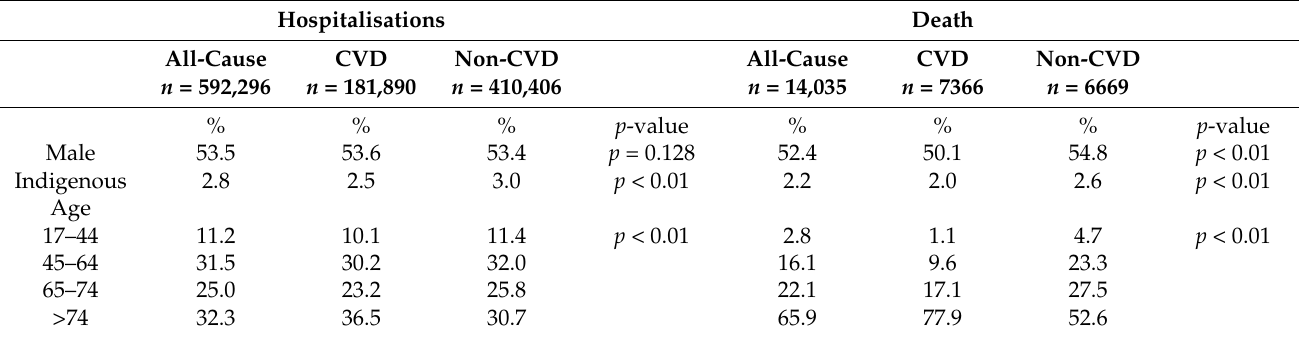
Table 1. Demographic characteristics of CVD- and non-CVD-related events.